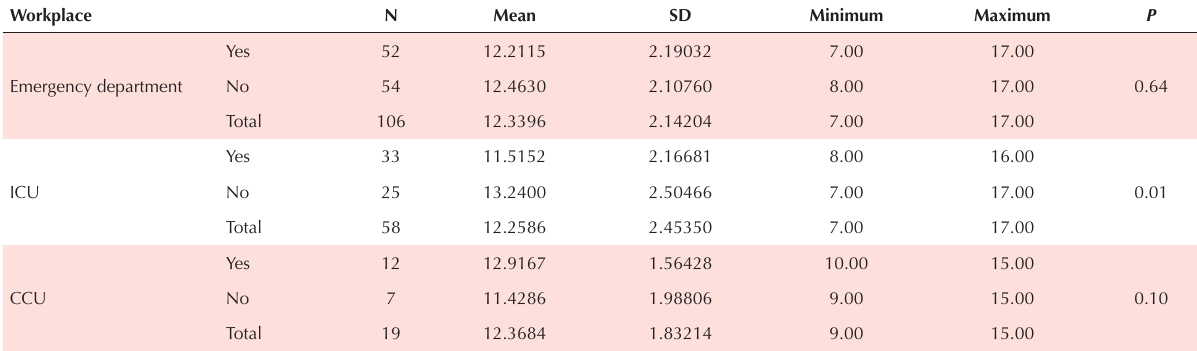
Table 3. Comparison of the Knowledge Scores of Emergency, ICU, and CCU Nurses Based on the Educational Course Workplace N Mean